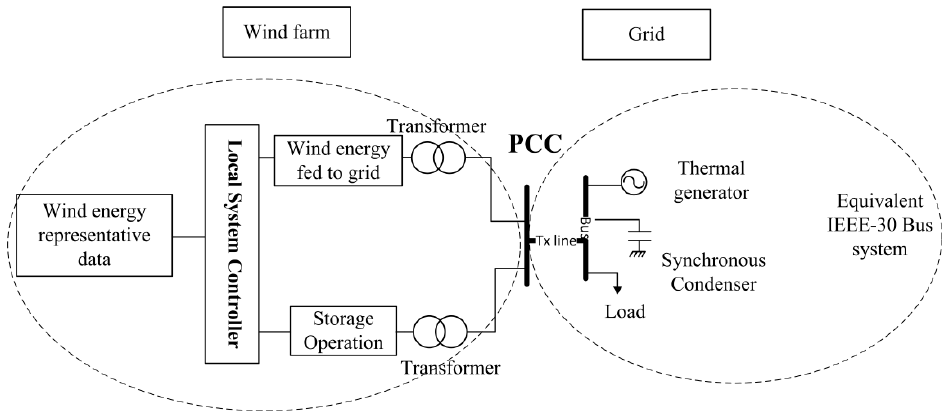
Figure 1. System diagram of the IEEE-30 bus system and the connected wind farm.